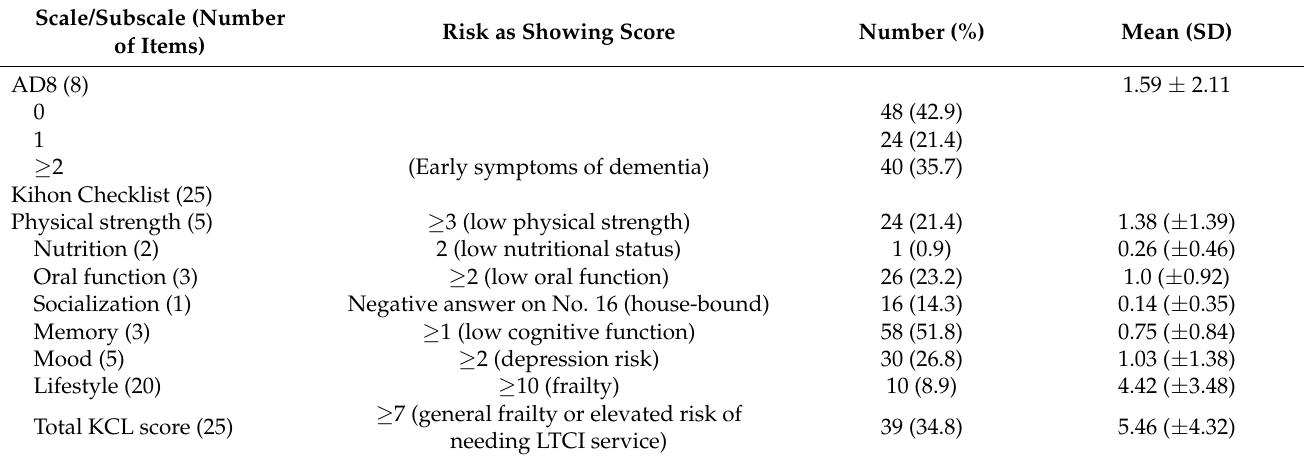
Table 2. Cognitive function and risk of frailty in the older adults with chronic disease ( n = 112).